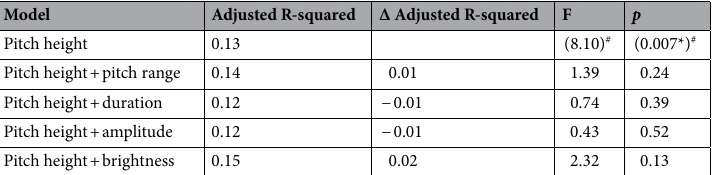
Table 2. Model comparisons. *Statistically significant at α = 0.05. # Compared to a null model (only including an intercept). The table provides statistical values for a stepwise multiple regression, in which one acoustical feature at a time is entered into the regression model. The first row ( Pitch Height ) shows results of statistical analysis for a model that includes only pitch height as a predictor of child’s age. Pitch height is a statistically significant predictor of child’s age as indicated by the p value in the first row. The subsequent rows ( Pitch Height + Pitch Range through Pitch Height + Brightness ) provide statistical values for the improvement of the model when the respective acoustical feature (e.g., Pitch Range in the second row) is included, compared to the Pitch Height-only model. For example, Pitch Height + Pitch Range did not explain significantly more variance in child age than Pitch Height alone as indicated by the p value in the second